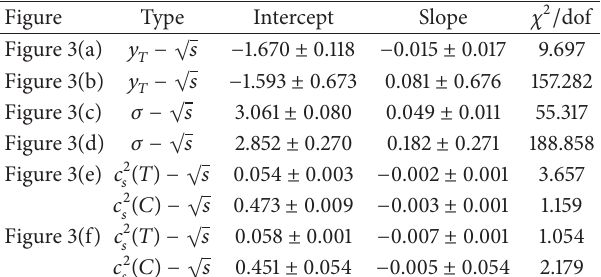
Table 2: Values of intercept, slope, and 𝜒 2 / dof corresponding to the linear fits in Figure 3, though some of them do not obey linear relations. The unit of √𝑠 is